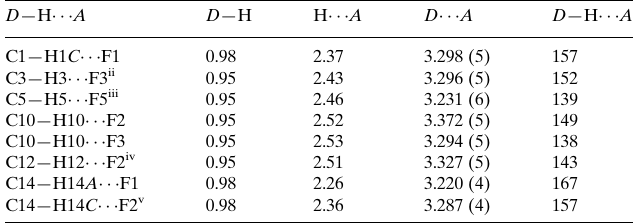
Hydrogen-bond geometry (A˚ , (cid:4)